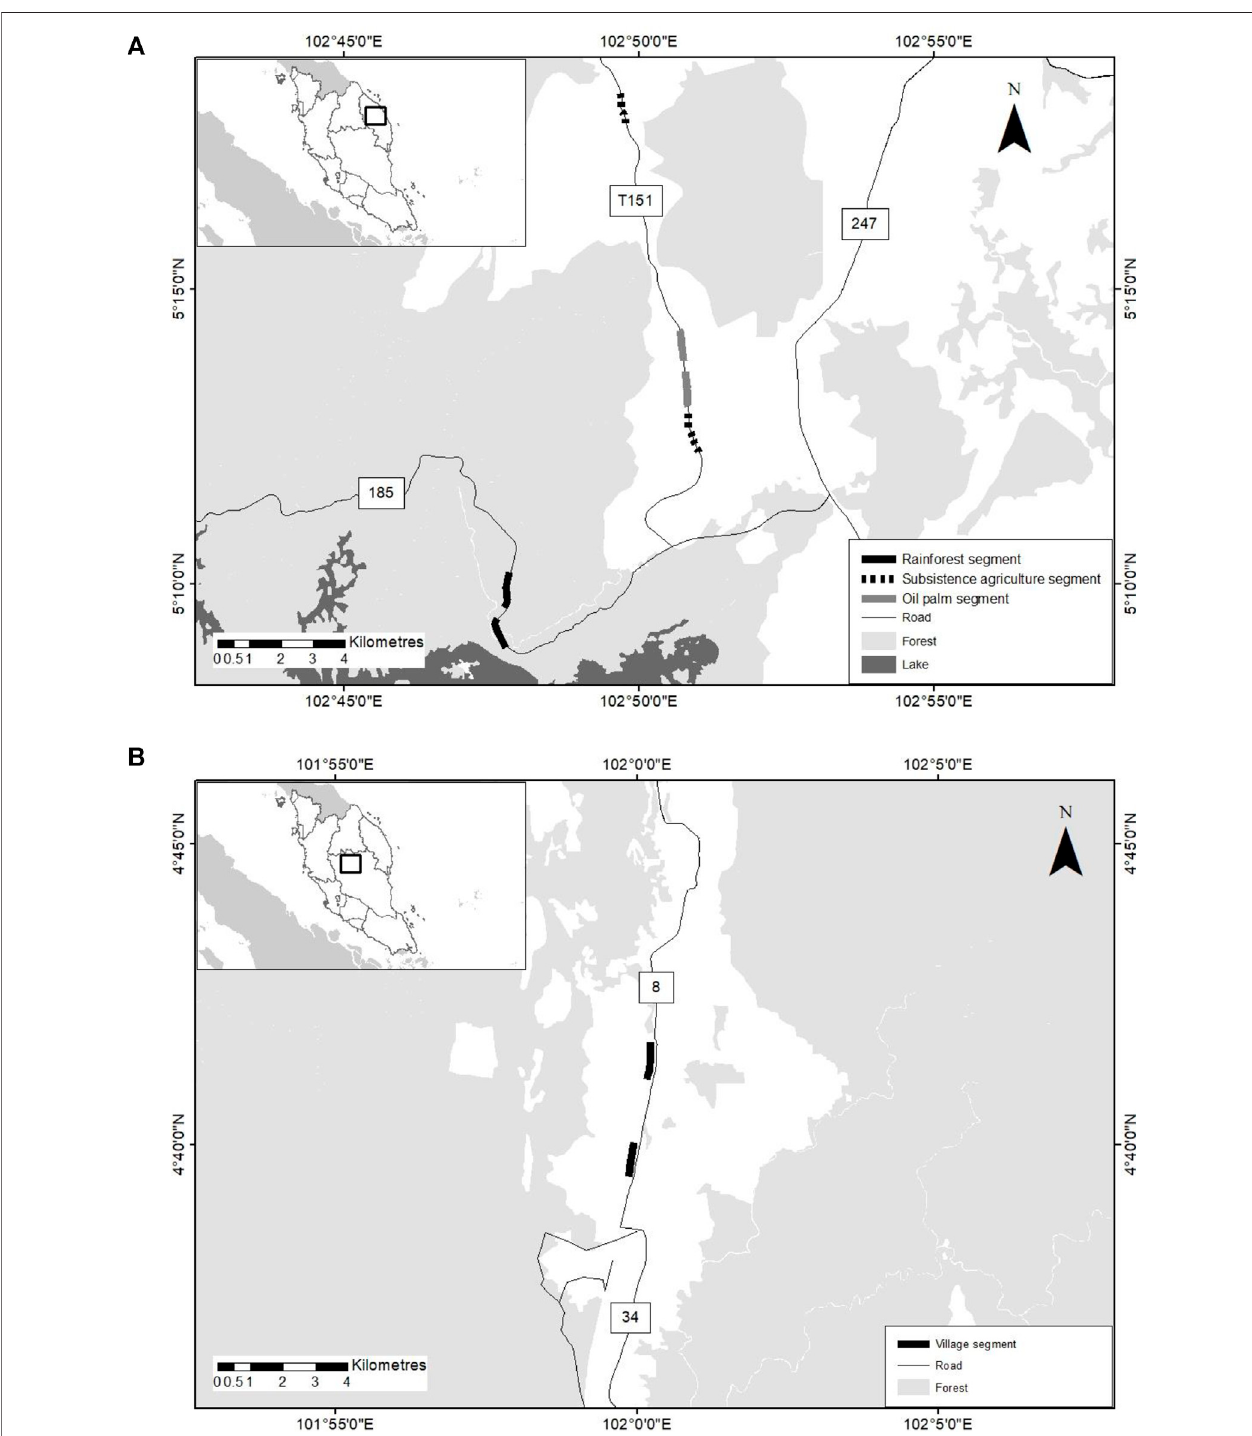
FIGURE 1 | Map of the surveyed road segments within Terengganu (A) and Pahang (B) , Peninsular Malaysia.